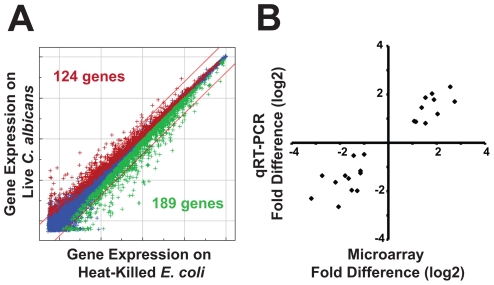
Infection with C. albicans yeast induces a rapid host response.(A) C. elegans genes that were differentially regulated in C. albicans-exposed versus heat-killed E. coli-exposed young adult animals at 4 hours after infection are depicted on a genome-wide intensity plot of 22,548 sequences. Genes colored red were upregulated by C. albicans (P<0.01), those colored green were downregulated (P<0.01) and those colored blue were unchanged. Diagonal lines represent 2-fold change and the numbers of genes differentially regulated greater than 2-fold are indicated (P<0.01)(124 genes were upregulated and 189 genes were downregulated). (B) qRT-PCR was used to confirm the results of the microarray analysis. 11 genes with varying degrees of differential regulation were selected and studied under each condition in which they were differentially regulated in the microarray analysis (see Table S2 for gene identities). Correlation of microarray and qRT-PCR data was determined by plotting the average fold difference observed in the microarray analysis (three biological replicates) versus the average fold difference for the same gene obtained by qRT-PCR (three biological replicates). Linear regression analysis revealed strong correlation between the datasets (R2 of 0.90).